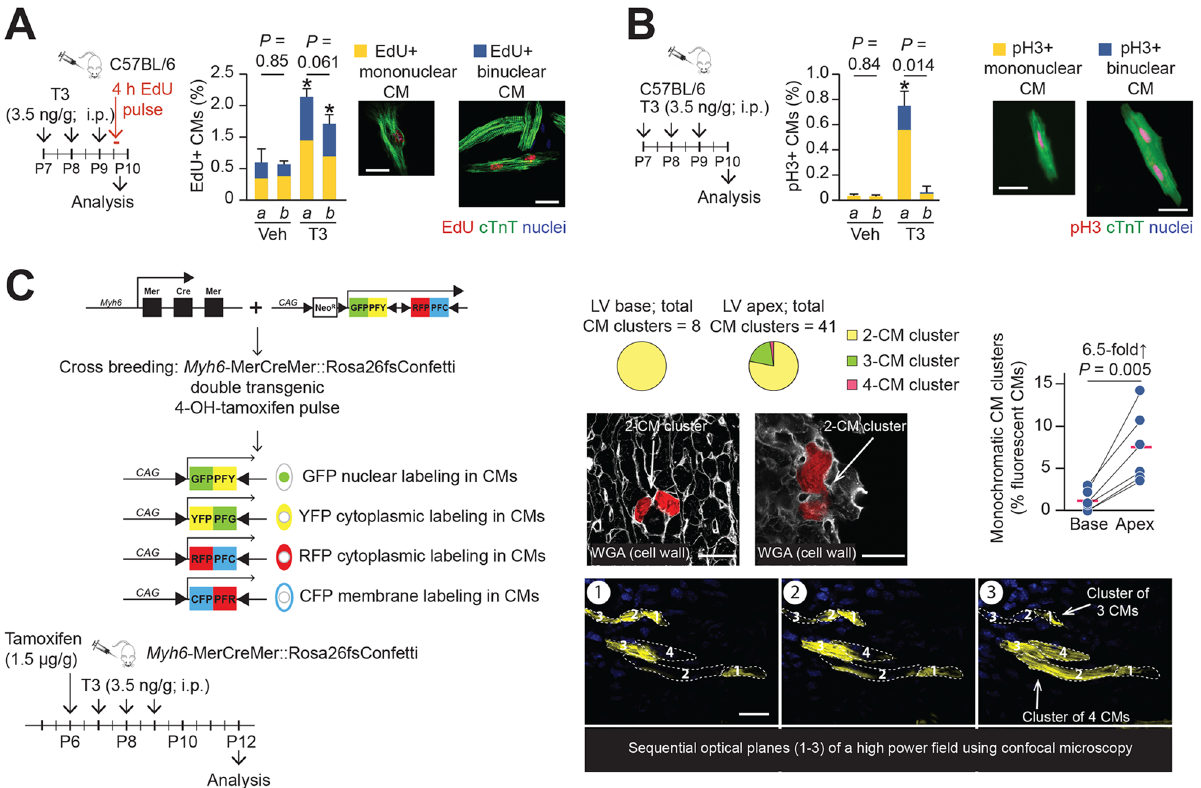
Figure 2. LV apical cardiomyocytes (CM) of post-P6 hearts proliferate in response to exogenous T3 versus vehicle. ( A , B ) Effects of T3 on DNA synthesis (EdU labeling) ( A ) and mitosis (pH3 labeling) ( B ) in cardiomyocytes from LV apex (a) or base (b). Cardiomyocytes were identified by cTnT labeling. * P < 0.05 for vehicle (Veh) versus T3 comparisons within each region using an unpaired Student’s t -test; n = 4. Intra-LV comparisons were made using a paired Student’s t -test; P -values for these comparisons are indicated. Between 500 and 2000 cardiomyocytes were analyzed for each assessment. ( C ) Multicolor labeling of post-neonatal mouse LV cardiomyocytes. Limited 4-hydroxytamoxifen-induced recombination of paired loxP sites (black triangles) leads to expression of green fluorescent protein (GFP), yellow fluorescent protein (YFP), red fluorescent protein (RFP) or cyan fluorescent protein (CFP) in a few cardiomyocytes, randomly positioned within the entire LV. Insets show examples of monochromatic clusters. Intra-LV comparisons were made using a paired Students t -test. Schematics illustrate experimental protocol. Error bars indicate SEM. White bars in photomicrographs represent 20